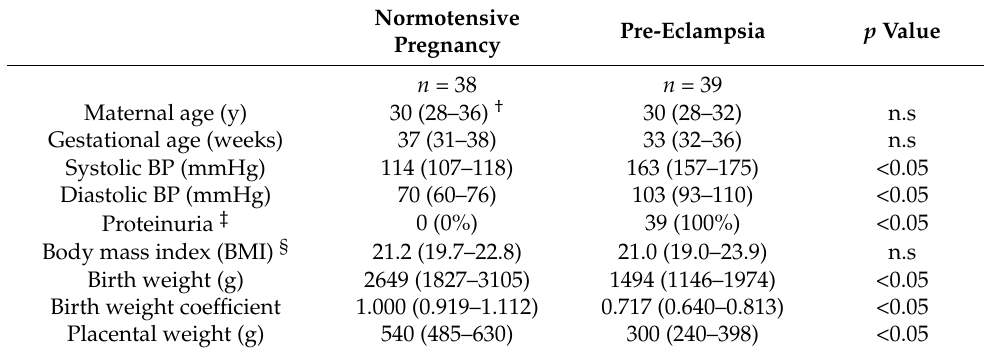
Table 1. Characteristics of the normotensive and pre-eclamptic study